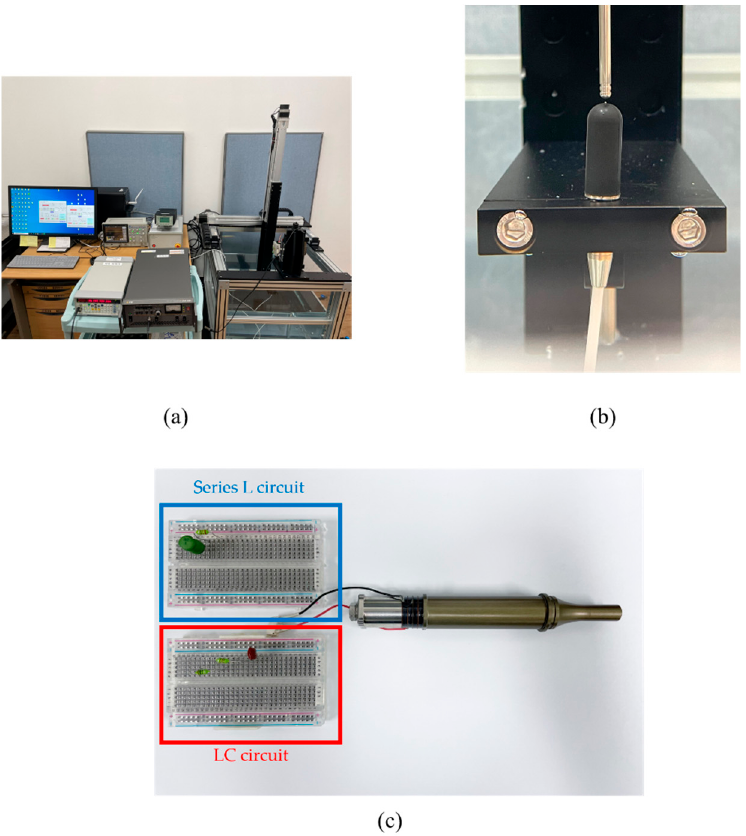
Figure 6. Pressure measurement setup. ( a ) overall system, ( b ) enlarged view of hydrophone and transducer tip in water tank, ( c ) transducer with matched circuits.